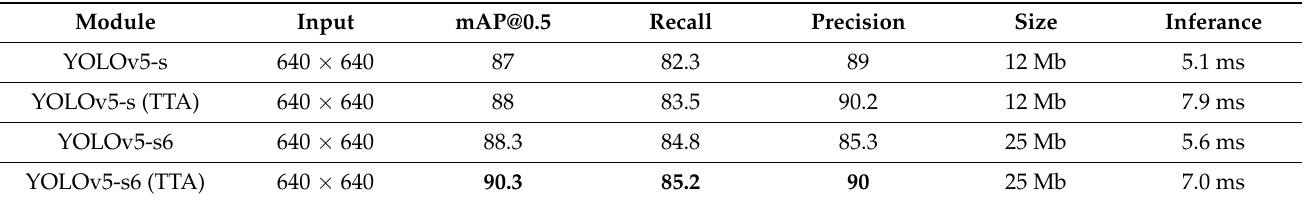
Table 3. Performances results using YOLOv5-s and YOLOv5-s6 on test images.